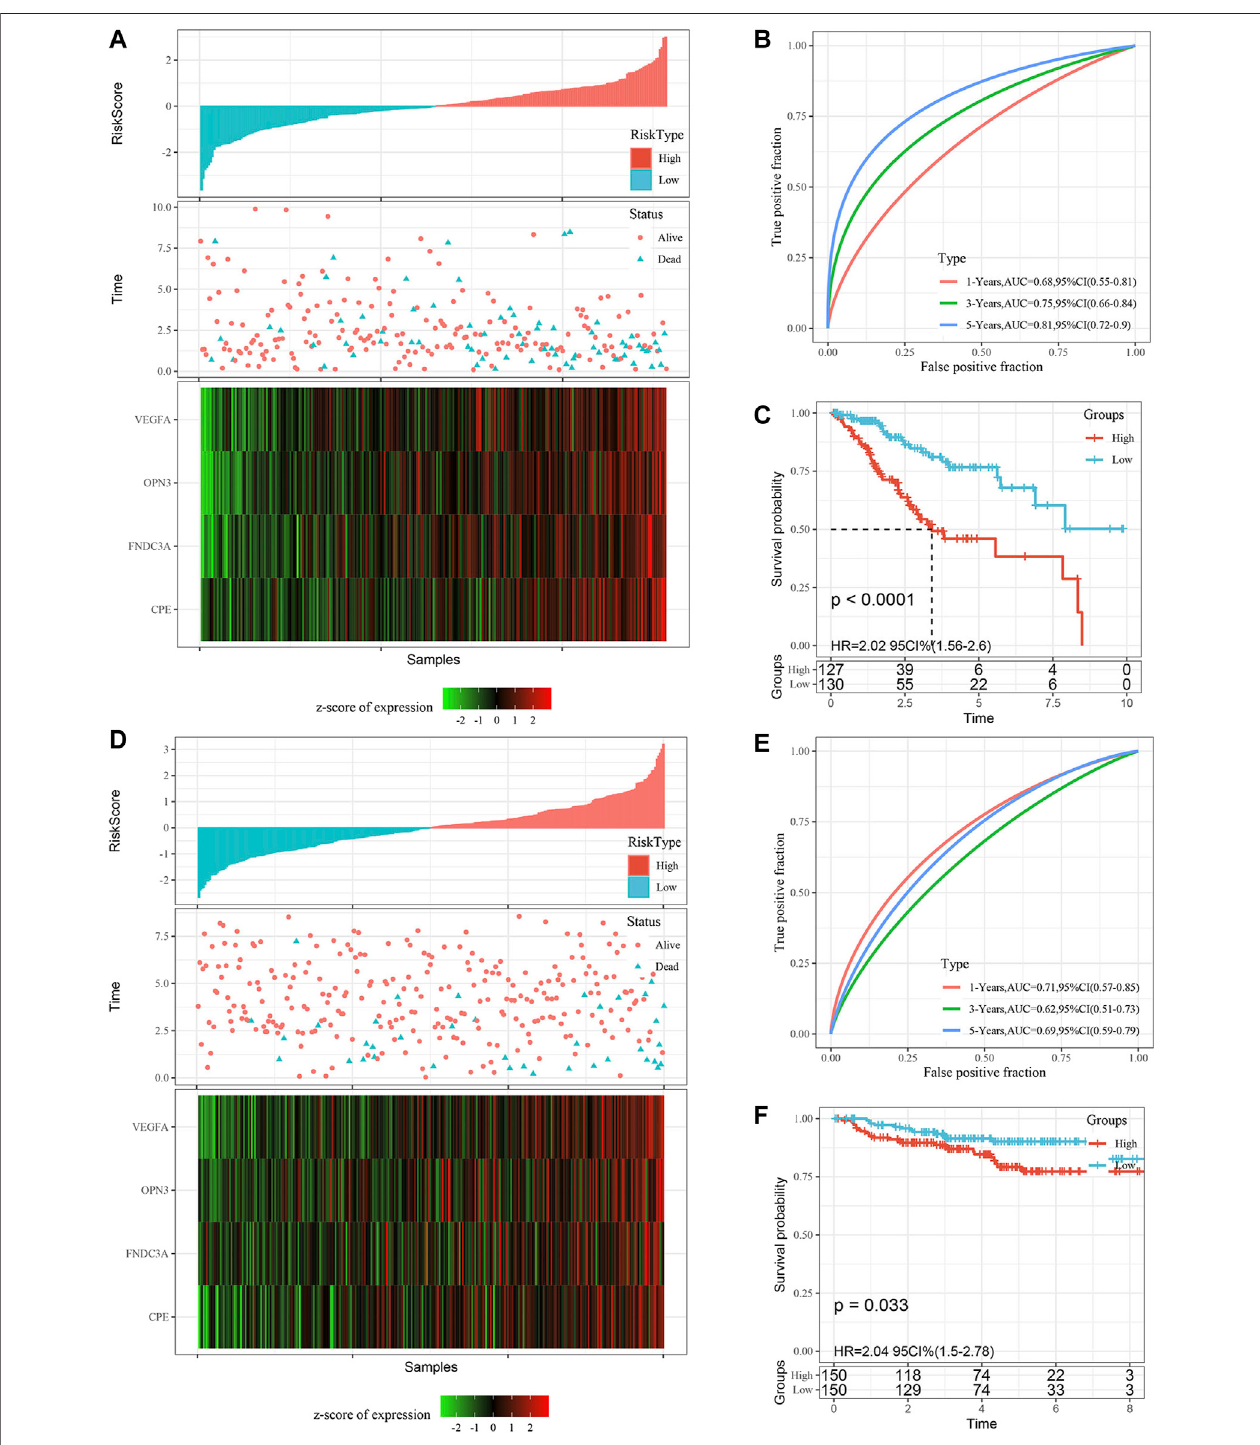
FIGURE 6 | Validation of the gene signature in the TCGA all set and the GSE44001 external validation set. (A) Risk score distribution in the TCGA all set. (B) ROC curveswere used toassess the ef fi ciency ofthe gene signature for predicting 1 year, 3years and 5 years survival rates in the TCGA all set. (C) The KM survival curves of the low-risk group and the high-risk group in the TCGA all set. (D) Risk score distribution in the validation set GSE44001, the survival time of validation set GSE44001 is progressionfreesurvival(PFS)time. (E) ROCcurveswereusedtoassesstheef fi ciencyofthegenesignatureforpredicting1year,3yearsand5 yearssurvivalrates in the validation set GSE44001. (F) The KM survival curves of the low-risk group and the high-risk group in the validation set GSE44001. Time: years.